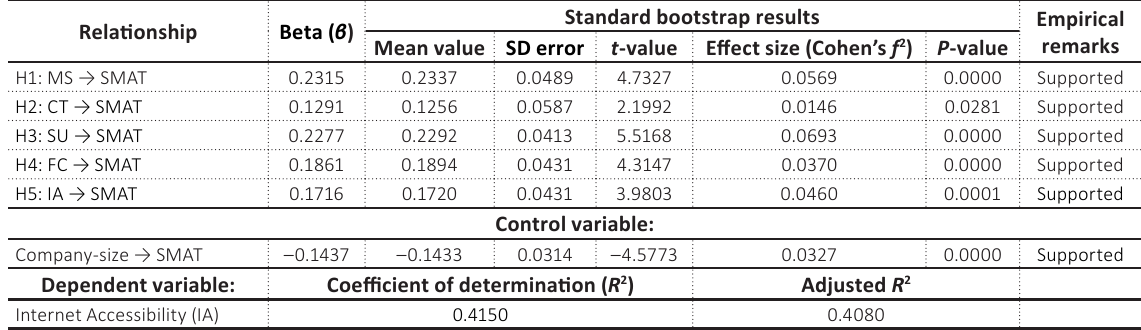
Table 6. Hypothetical path coefficient